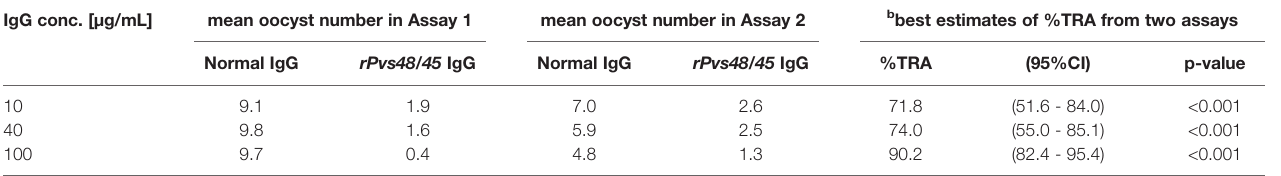
TABLE 2 | DMFA with human anti-CHO- rPvs 48/45-speci fi c IgG a . IgG conc.